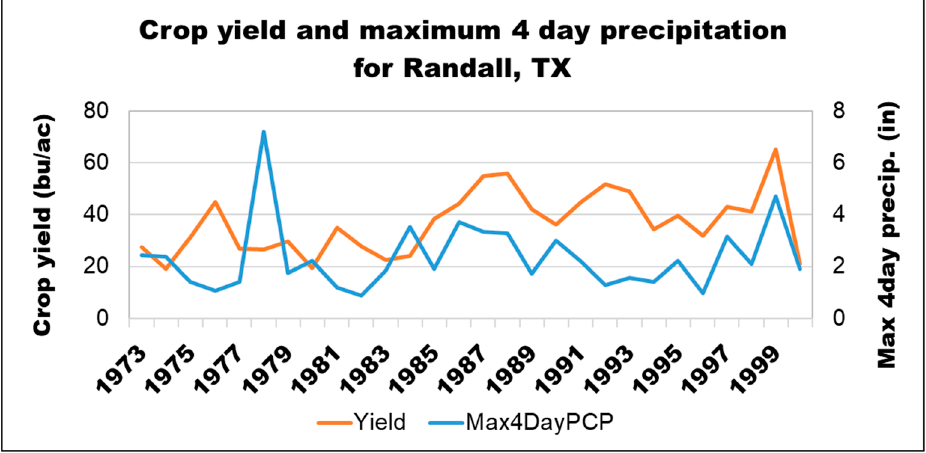
Figure 5. Sorghum yield reductions for Randall County in 1978 coming from maximum 4-day total precipitation.